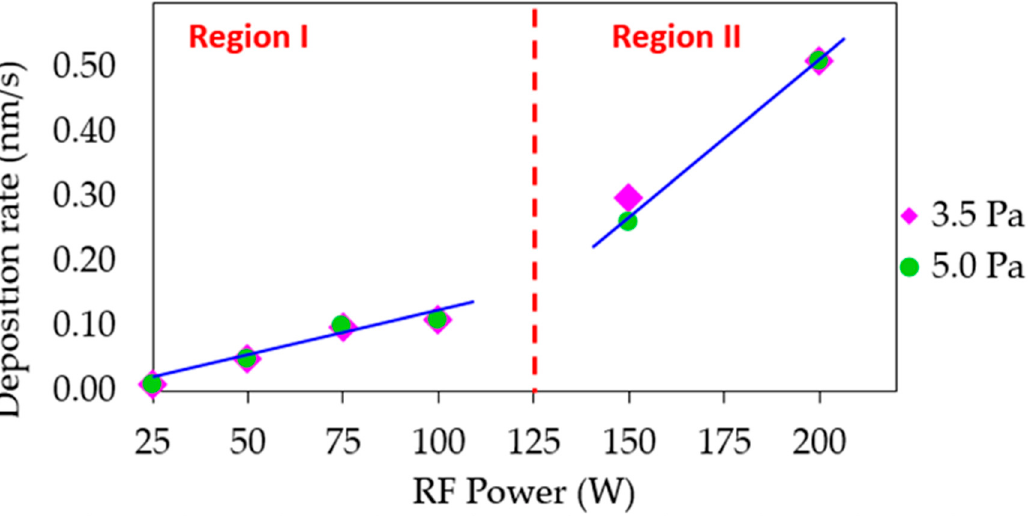
Figure 2. Deposition rate calculated for Cu 3 N samples prepared at different RF power values and gas pressures. The line is a visual guide. gas pressures. The line is a visual